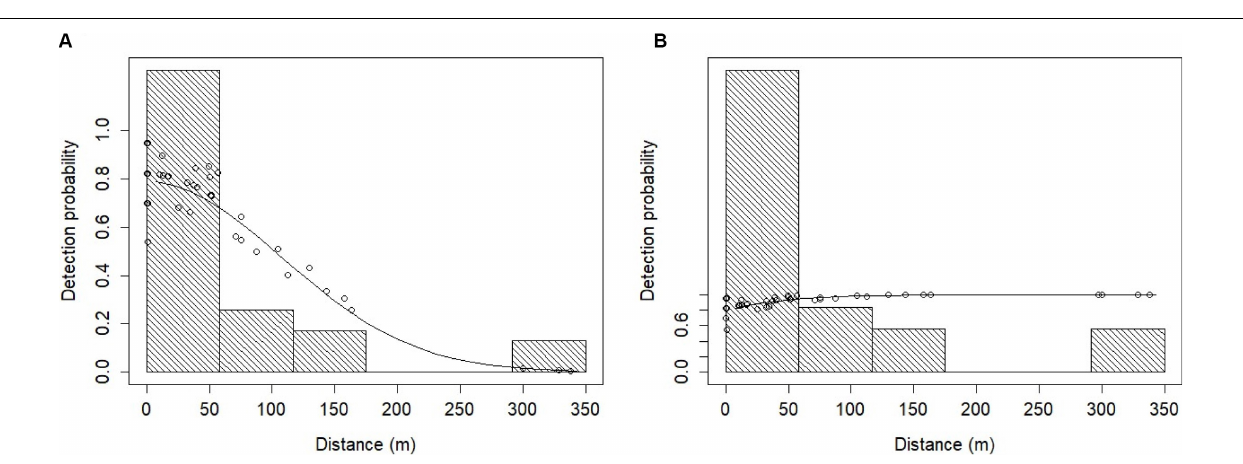
FIGURE 5 | Fitted MRDS and MR models for the Heaviside’s dolphin data under: (A) the point independence (PI) assumption, and (B) the full independence (FI) assumption. The solid line represents the fitted model and the dots represent the detection probabilities for individual primary platform detections. The histogram bars represent the perpendicular distances (m) of Heaviside’s dolphin detections truncated to 350 m. The probability of detection is above 1.0 at perpendicular distances 0 – 50